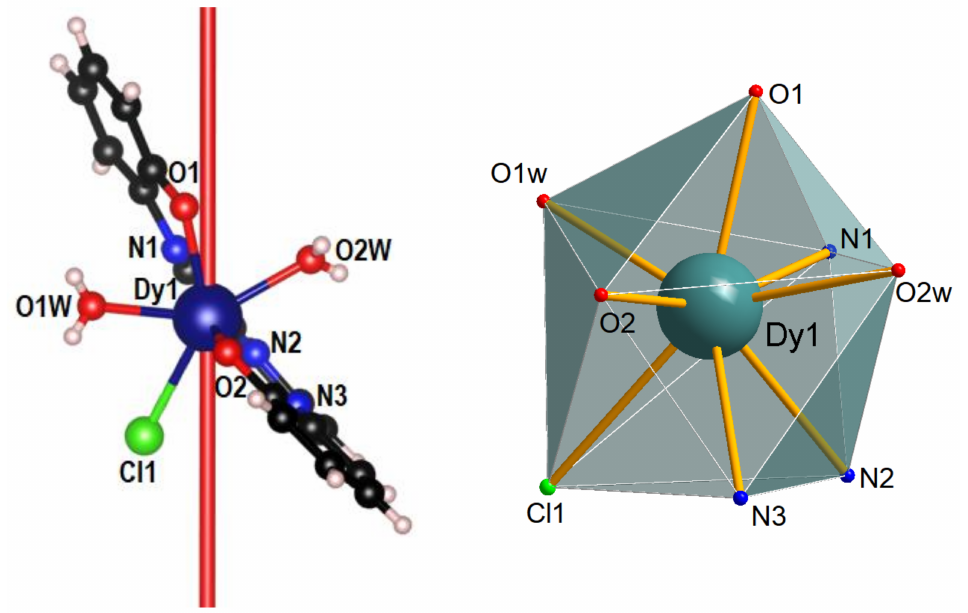
Figure 6. ( Left ) Calculated orientation of the local main magnetic axis (red) on Dy III ion for 1 using MAGELLAN software [24]. ( Right ) Coordination polyhedra for de Dy III ion in 1 , showing O1 at the apex of the distorted biaugmented trigonal prism